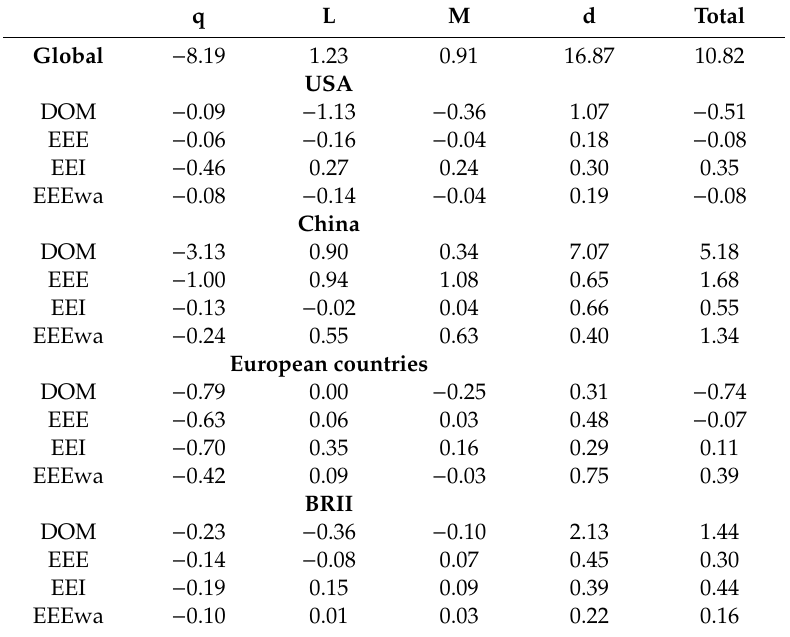
Table 1. Drivers of change in emissions, globally and in some major economies and country groups. Gigatons Gt of CO 2 . Results for all countries are found in the SI. q L M